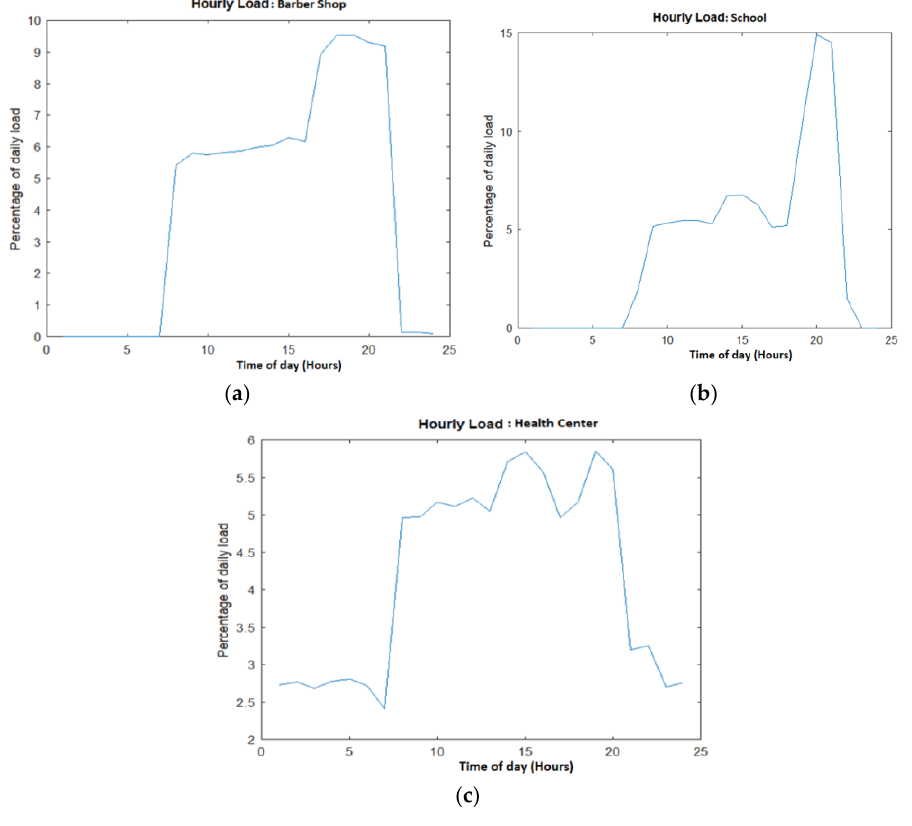
Figure 10. Load profiles for the barbershop (a), school (b), and health centre (c).